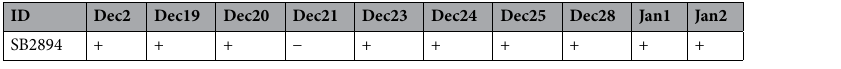
Table 1. Serial crAssphage detection from cat